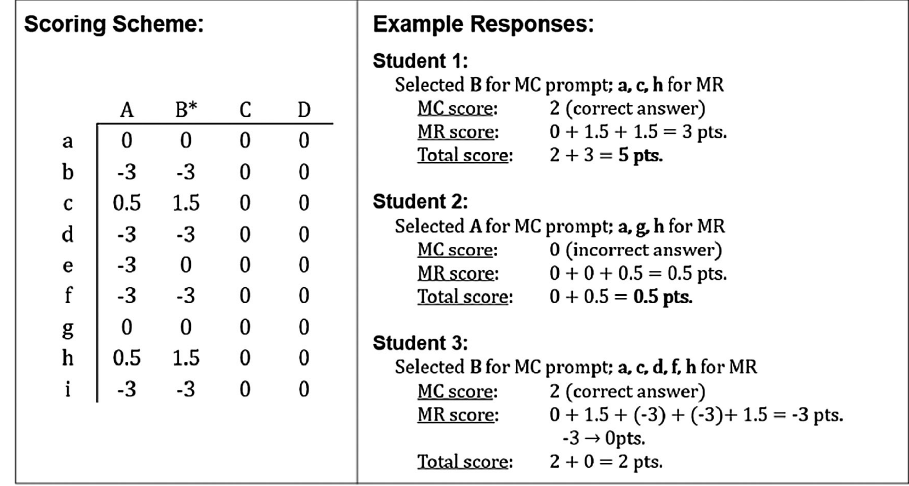
FIG. 2. Scoring scheme (left) and application examples (right) for item 1 of the U-STEP (Fig. 1). Multiple choice (MC) options (A – D) are in the top row of the scoring scheme, while the leftmost column lists multiple-response (MR, reasoning) options. Students select one MC answer and as many MR options as they desire in order to support their response. All other entries within the table are scores assigned to each response. The * indicates the correct MC response. See Supplemental Material [50] to see other items and their scoring